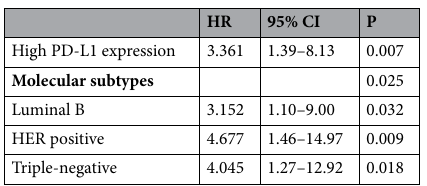
Table 2. Cox proportional hazard regression analysis for the association between PD-L1 expression in tumour, molecular subtypes and PFS adjusted for age.